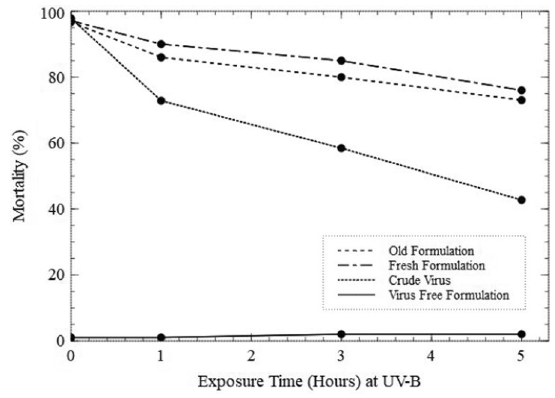
Fig. 3 Efficacy of crude virus, fresh, old formulations, and virus-free formulation on third instar Hyphantria cunea after UV-B